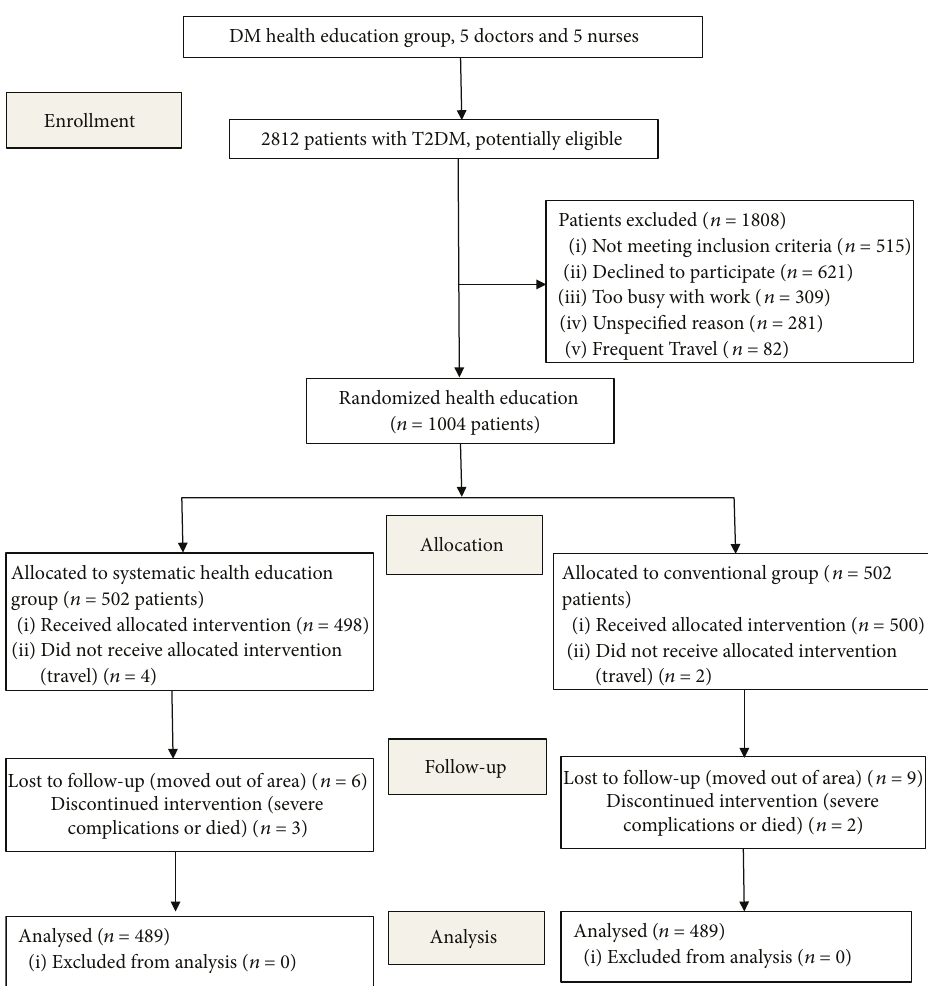
Figure 1: Flow diagram of